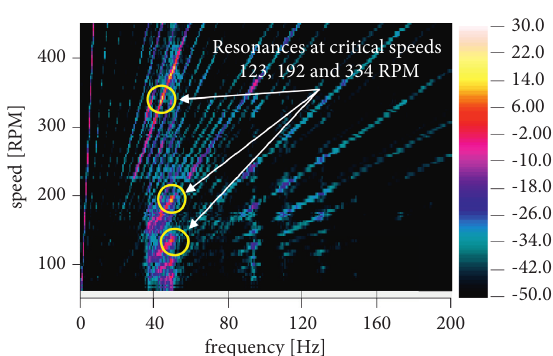
Figure 6: Campbell diagram: 4 pairs of EMs, 2N prestressed contacts. Figure 6 is reproduced from